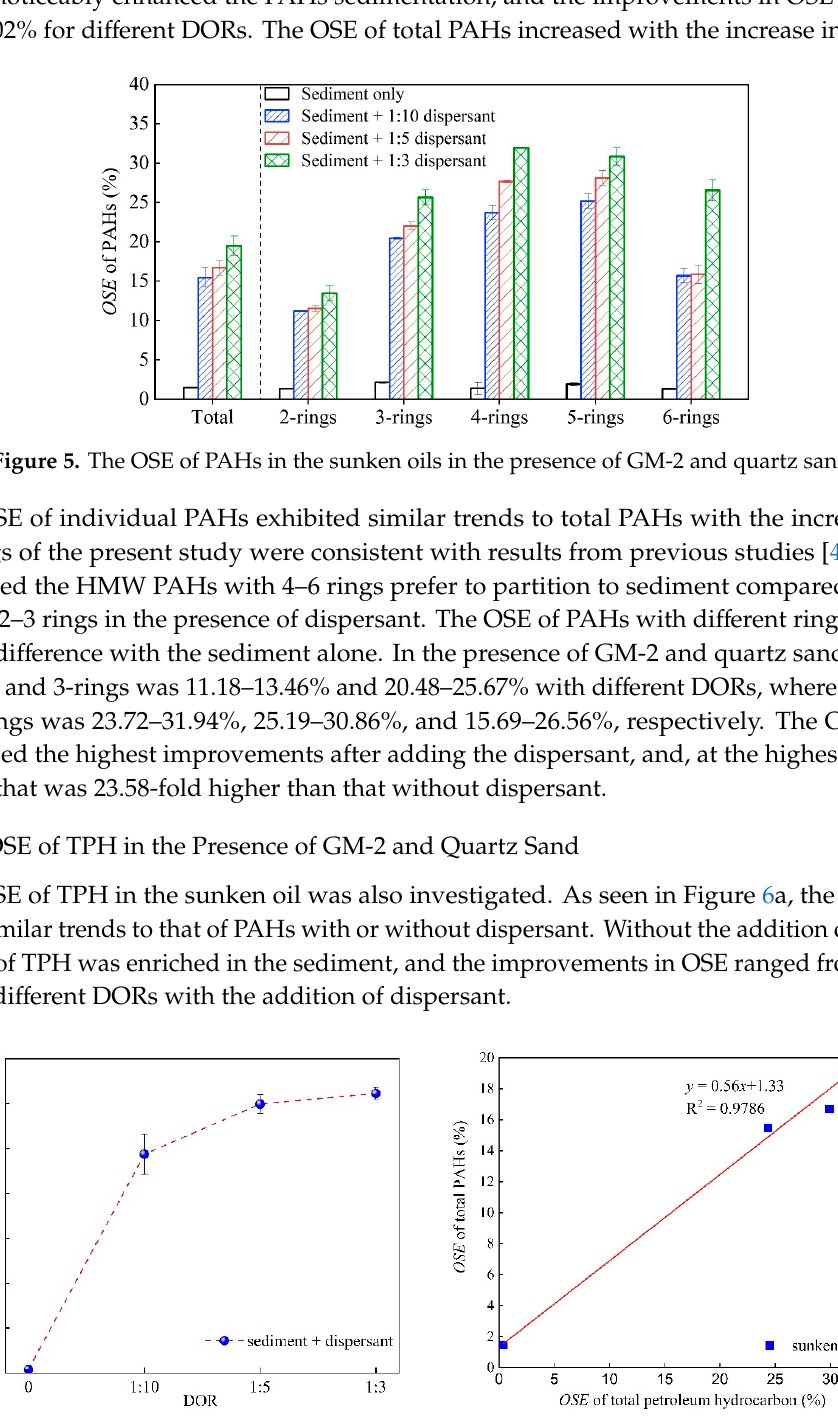
Figure 4. The distribution of PAHs in the sunken oils in the presence of GM-2 and quartz sand.